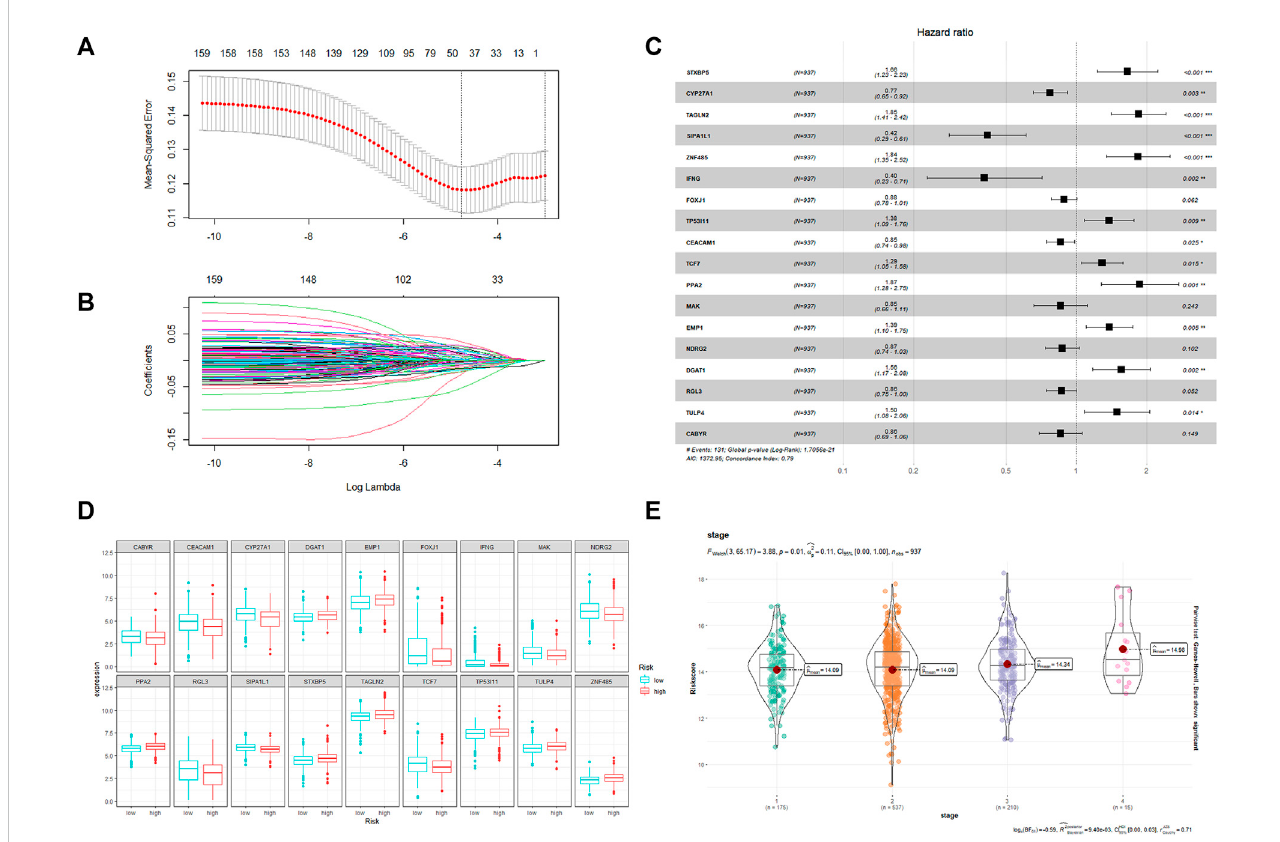
FIGURE 2 (A) The LASSO Cox regression model was utilized to identify CRRGs. (B) Select range of the optimal parameter (lambda) in the LASSO Cox regression model. (C) The coef fi cient of the selected CRRGs. (D) Expression of 18 CRRGs in the high and low risk groups. (E) The distribution of the CRRGs risk score in different TNM stages of TCGA-BRCA